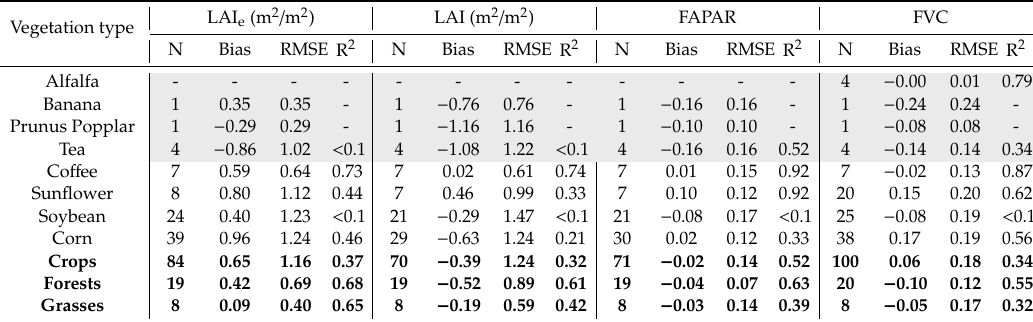
Table 3. Direct validation results of Sentinel-2 biophysical estimates over di ff erent vegetation types. The “N” and “-” denote the number of valid pixels and unavailable results, respectively. The gray color in the table indicates few ground ESUs were used to evaluate the Sentinel-2 biophysical estimates, while the bold numbers show the validation results for crops (including alfalfa, banana, Tea, ect.), forests, grasses,